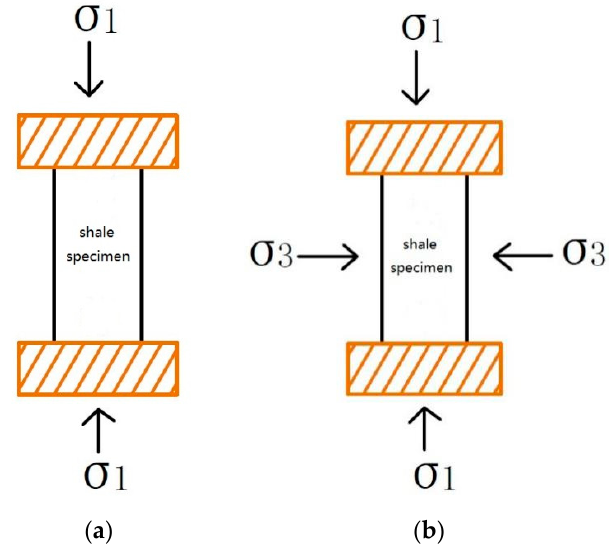
Figure 1. Schematic of shale sample subject to ( a ) uniaxial and ( b ) triaxial compression.